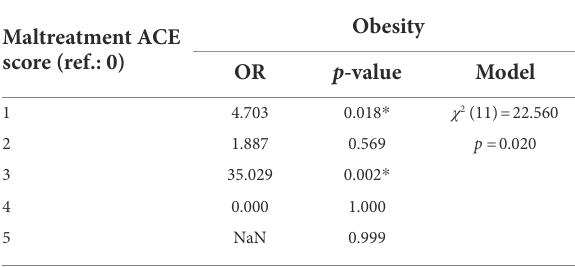
TABLE 5 Adjusted odds ratios for obesity by the number of maltreatment forms.